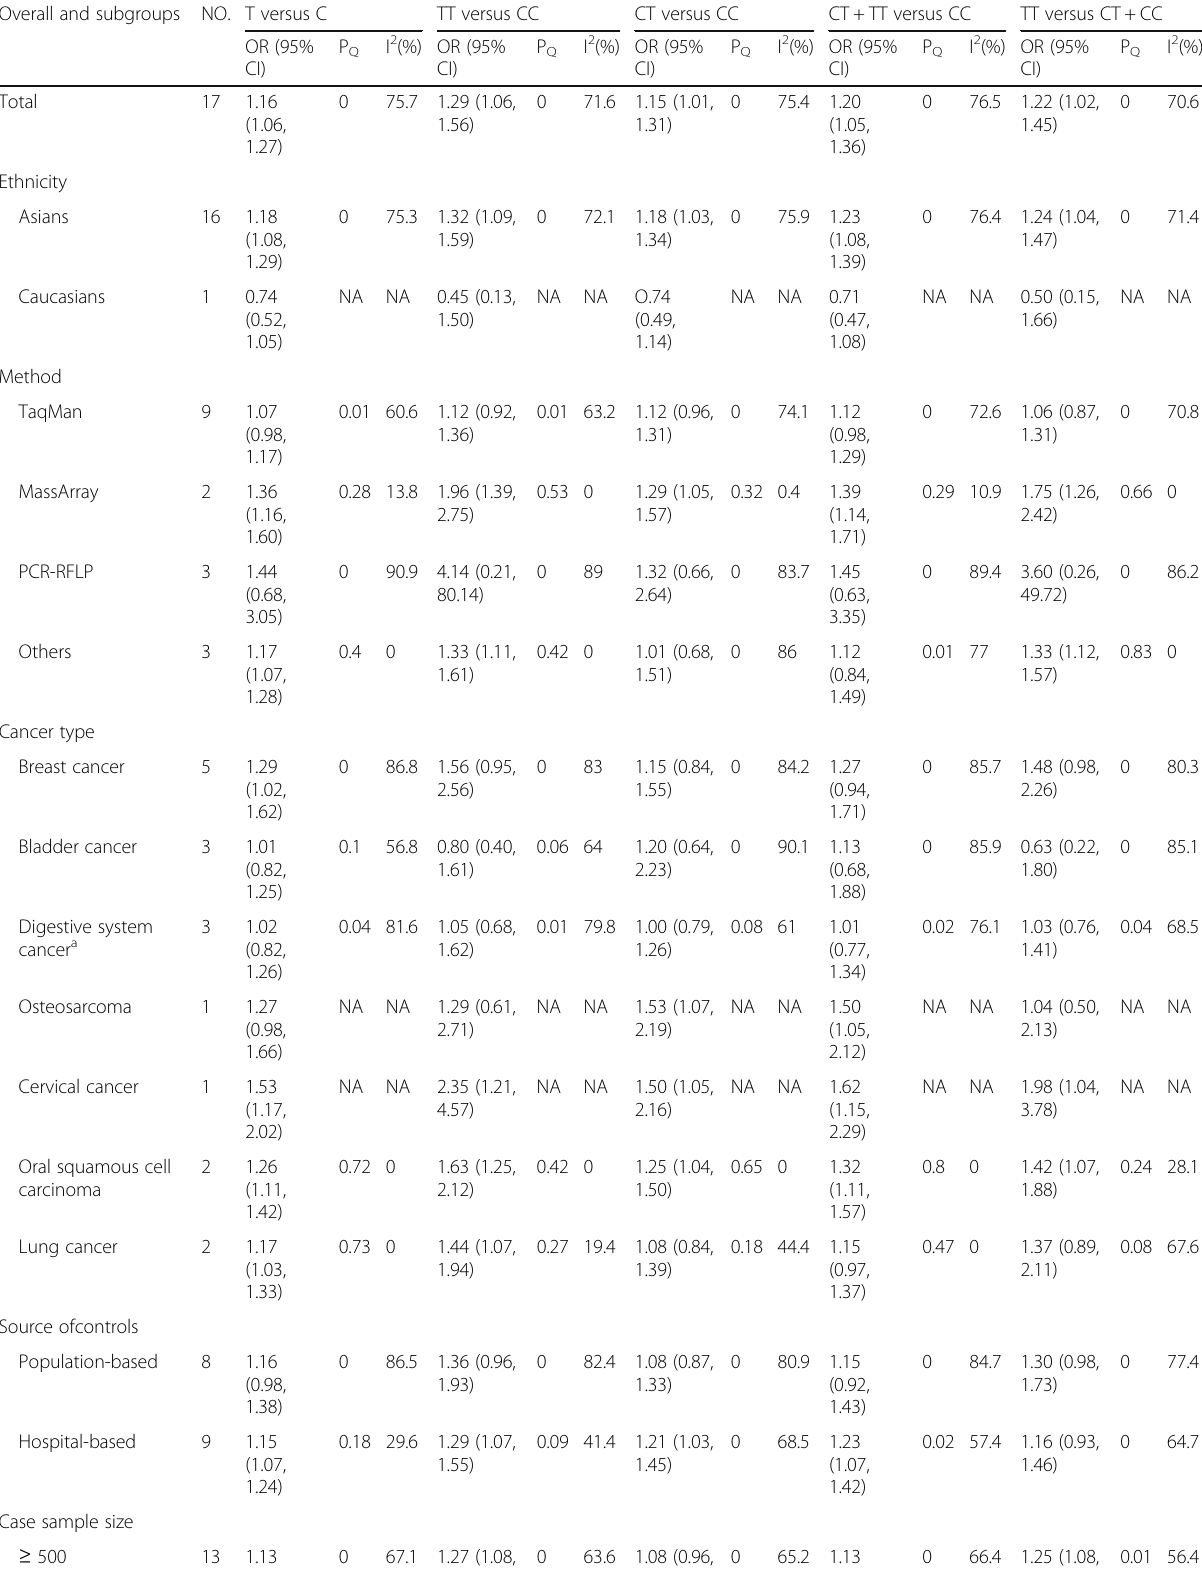
Table 4 Overall and subgroups meta-analysis of H19 rs217727 (C > T) polymorphism and cancer risk Overall and subgroups NO. T versus